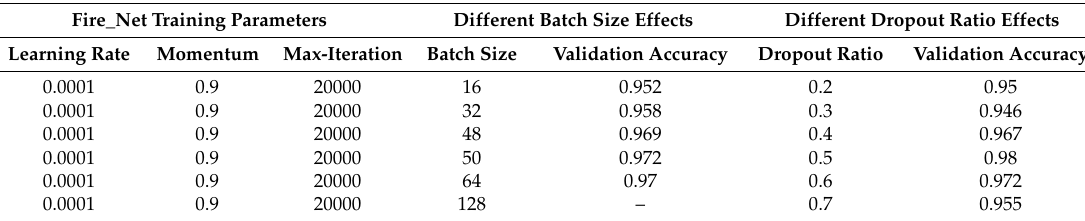
Table 5. Different dropout ratio and batch size effects on validation accuracy.